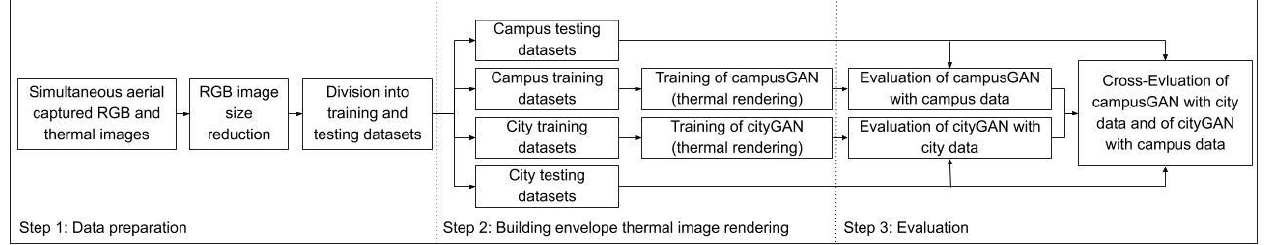
Figure 1. Research method flowchart.